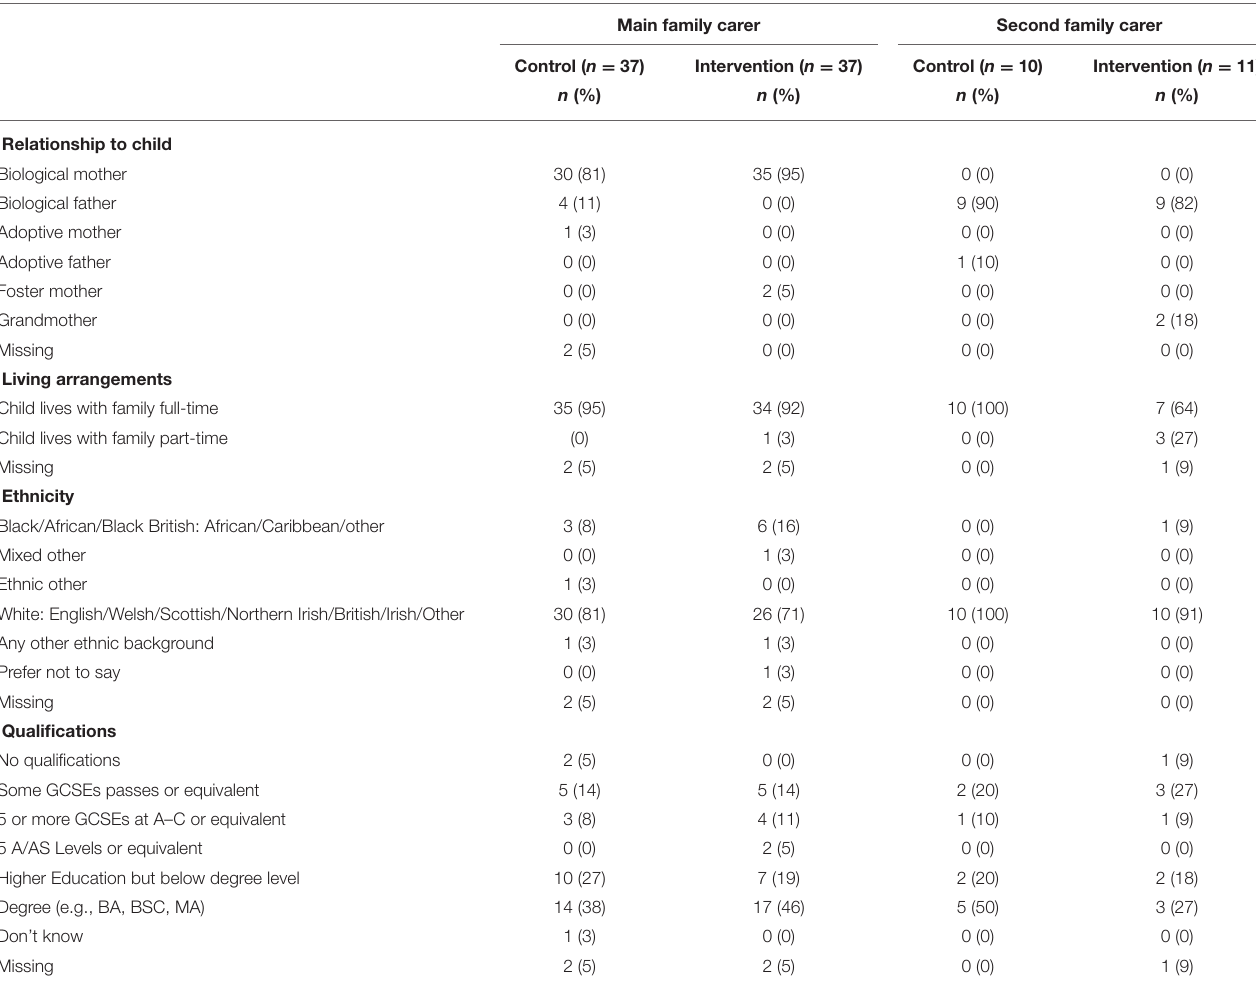
TABLE 3 | Participant demographics split by trial arm and family carer status.